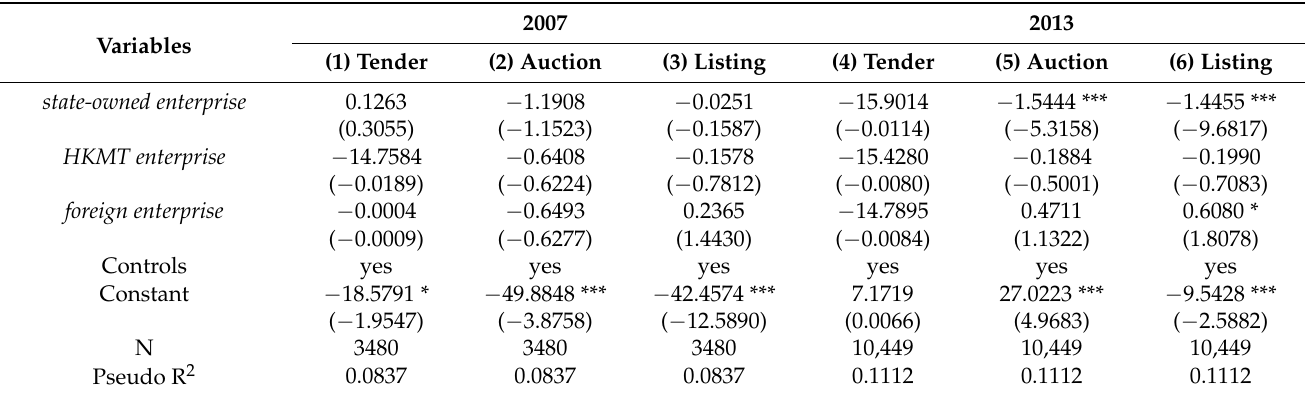
Table 5. Results of mlogit model considering types of